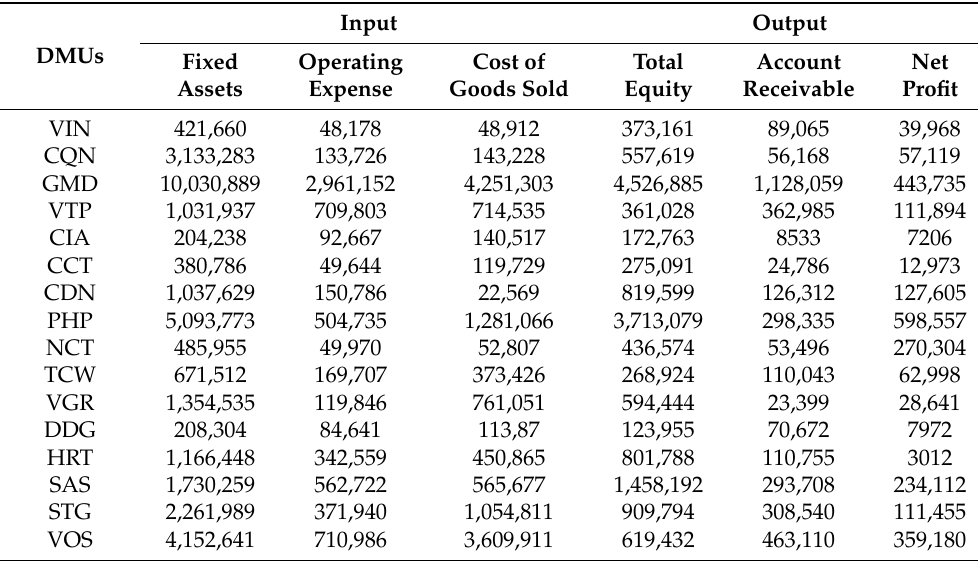
Table 2. The data of Vietnam logistics company 2018 (Unit: million dong).